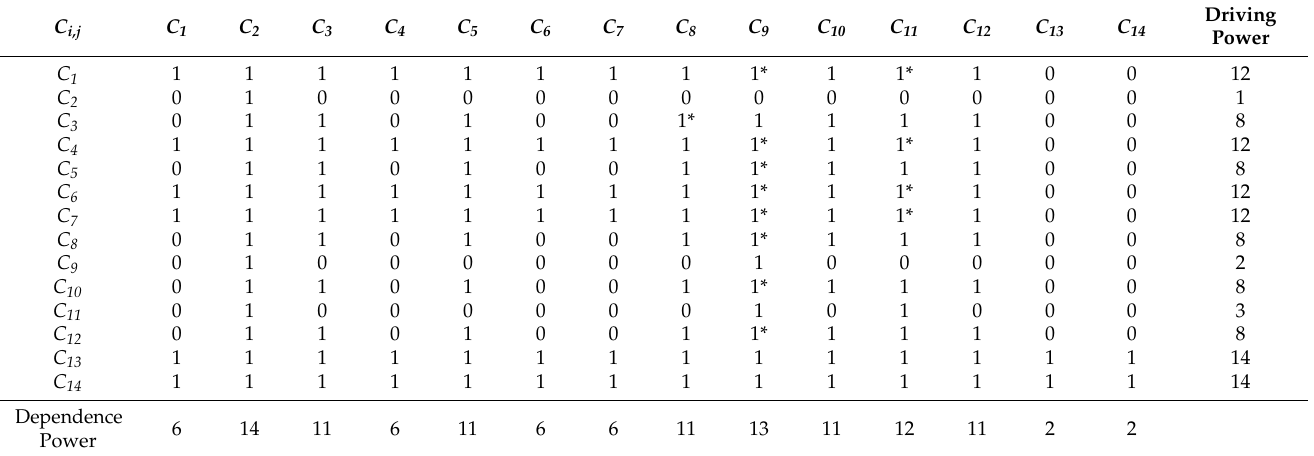
Table 5. Final Reachability Matrix (FRM) of critical Systems-Thinking-based leadership competencies as enablers to better construction safety